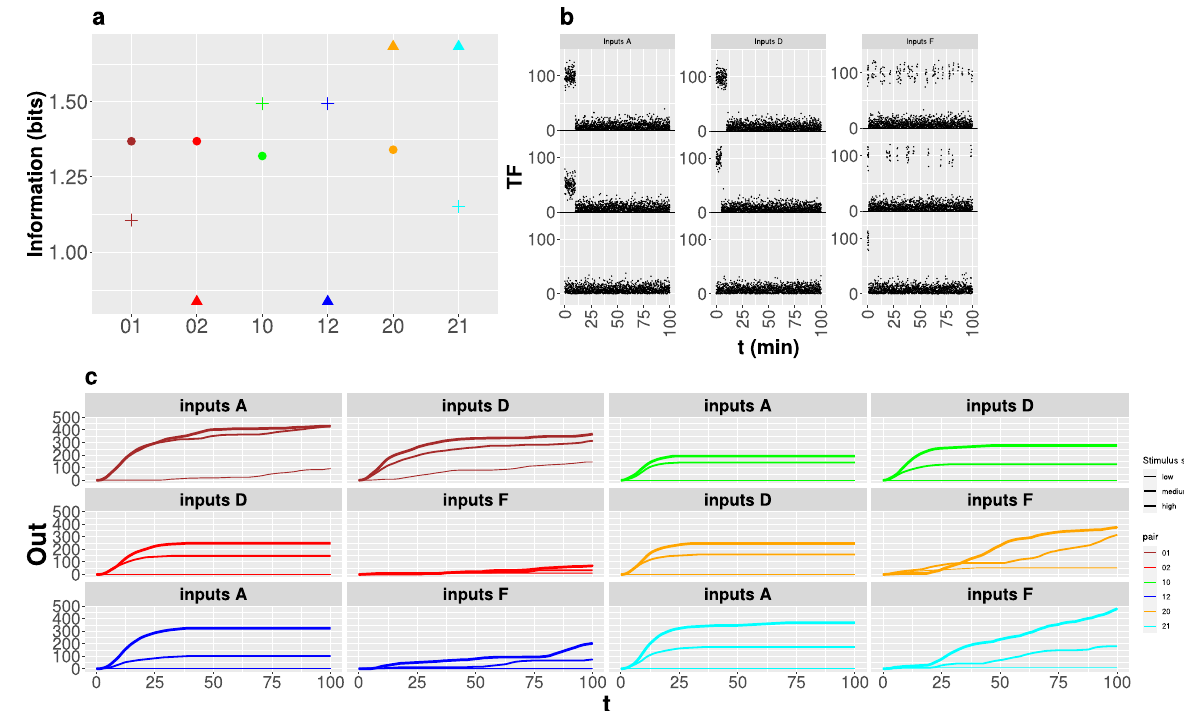
Figure 6. Mutual information and dynamical behaviors obtained using the set in each Minmax region that minmizes MI for the “second” modulation type. ( a ) MI computed using the selected set of parameters in each Minmax region for the input modulation modes that are maximized and conditionally minimized to determine the region (circles: duration, crosses: amplitude, triangles: frequency) and the T c output time cut. The labels on the horizontal axis identify the Minmax regions with the digits order as in Fig. 5. Each parameter set is identified by a different color. The parameter values in each set are displayed with symbols in Fig. 5b,c. Accumulated mRNA ( Out (time)) as a function of time ( c ) obtained from simulations of the model using the TF time courses displayed in ( b ) (curves in c are plotted with increasing thickness with stimulus strength) and the same parameter sets (identified by the same color) as in ( a